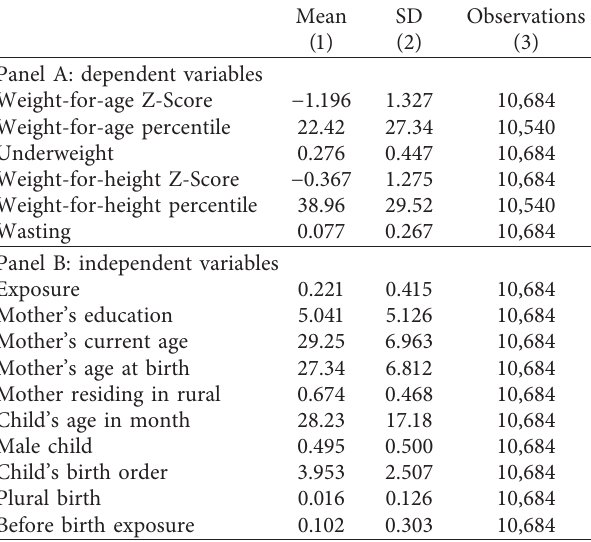
Table 2: Summary